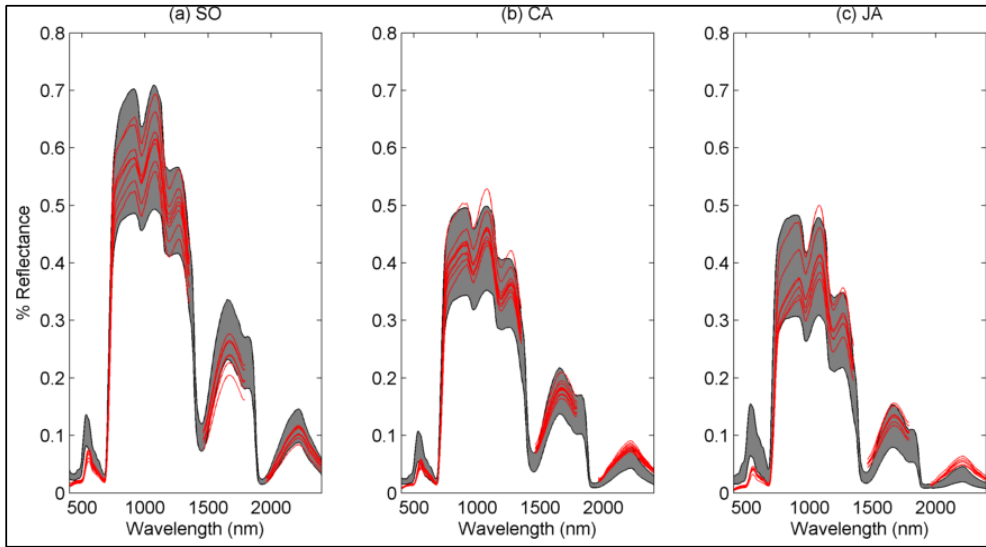
Figure 7. ( a – c ) PROSAIL model ensemble runs for each target species simulated for every possible combination of leaf and canopy optical parameters. Red lines show average spectra measured on 12 and 13 June 2014 at each sampling location for respective species.